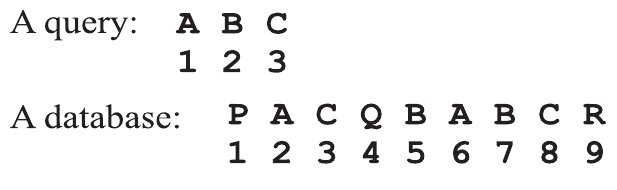
Figure 5. An example to show how the SP model finds good full and partial matches between patterns. A “query” string and a “database” string are shown at the top with the ordinal positions of symbols marked. Sequences of hits between the query and the database are shown in the middle with corresponding values of p (described in BK , Section A.2). Each n node in the hit structure shows the ordinal position of a query symbol and the ordinal position of a matching database symbol. Each path from the root node to a leaf node represents a sequence of